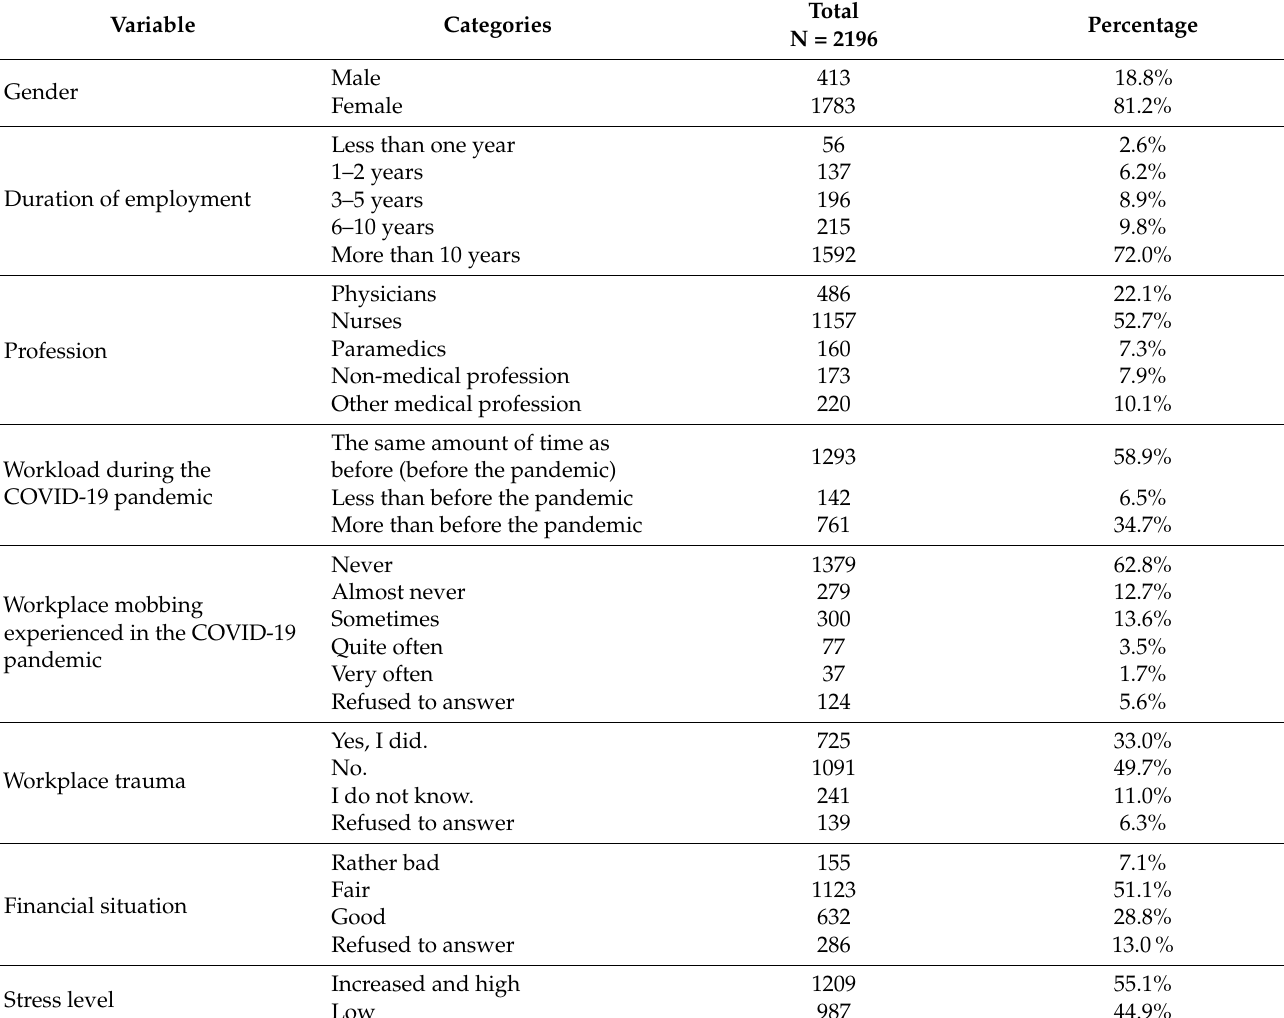
Table 1. Sample characteristics (all data presented as percentages; N = 2196).